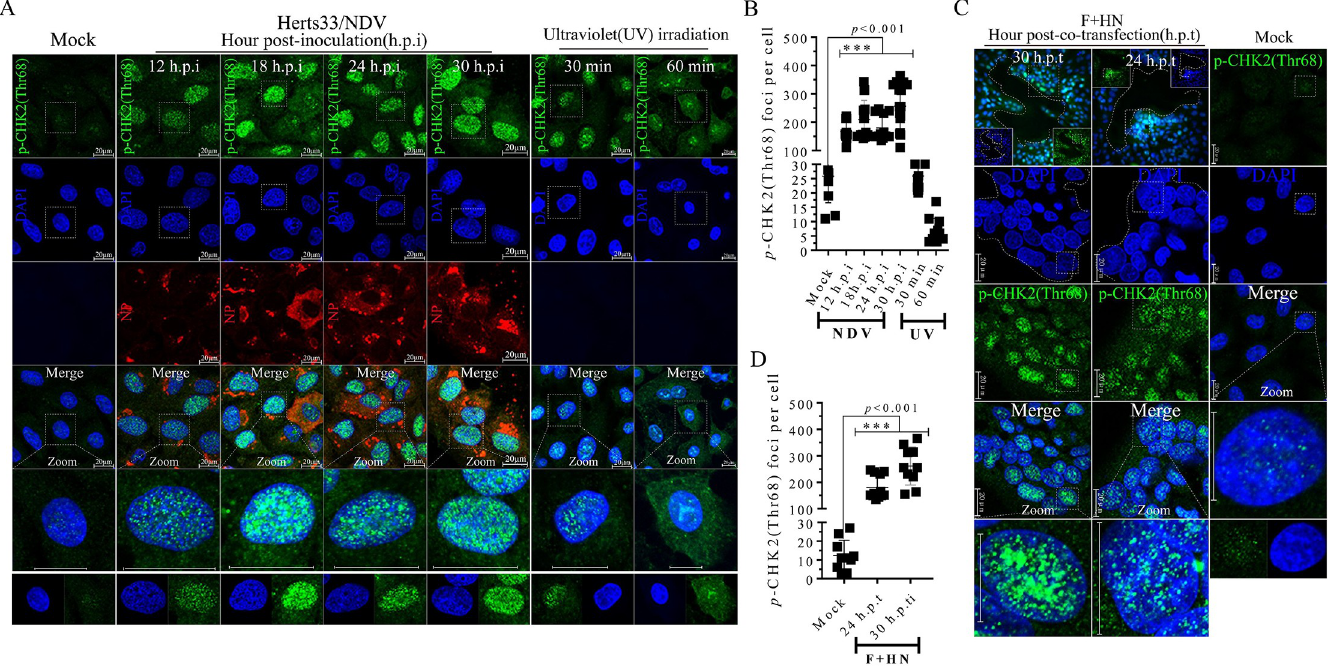
Fig 5. NDV late infection and membrane fusion activated the ATM-Chk2 axis in A549 cells. (A) Representative images showing that virulent oncolytic NDV infection triggered nuclear aggregation of phosphorylated Chk2 on Thr48 in A549 cells. A549 cells were mock-infected and NDV-infected (MOI = 1) for 12, 18, 24, and 30 h, and UV exposed for 30 and 60 min. After treatment, the A549 cells were collected, fixed, and visualized by IFA. The UV-exposure group served as the positive control. Phosphorylated Chk2 (green); nuclei (blue); NDV (red). Scale bars = 20 μ m. (B) Statistical analysis of the nuclear aggregation punctate foci numbers of phosphorylated Chk2 on Thr 48 in response to virulent oncolytic NDV infection in A549 cells. Numerical data were the average number of punctate foci in different microscope fields in at least three independent experiments. Significance was analyzed using two-tailed Student’s t-test. The UV-exposure group served as the positive control. NS, p > 0.05; � , p < 0.05; �� , p < 0.01; ��� , p < 0.001. (C) Representative images showing that F-HN co-expression triggered nuclear aggregation of phosphorylated Chk2 on Thr 48 in A549 cells. A549 cells were mock transfected or co-transfected with both Flag-F and HA-HN plasmids at the indicated time. At 24 and 30 h.p.t., coverslips were examined by IFA. Phosphorylated Chk2 (green); nuclei (blue); NDV (red). Scale bars = 20 μ m. (D) Statistical analysis of the nuclear aggregation punctate foci number of phosphorylated Chk2 on Thr 48 in response to F-HN